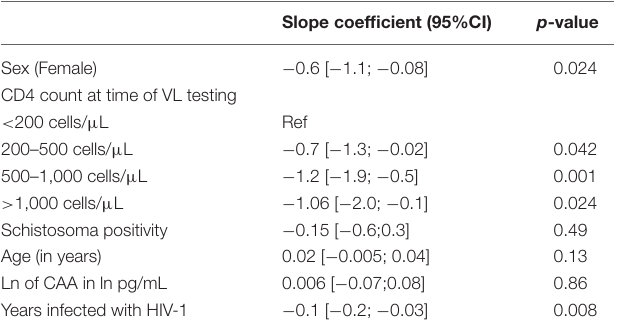
TABLE 2 | Results of the univariable analysis with log 10 of viral load as a continuous outcome.